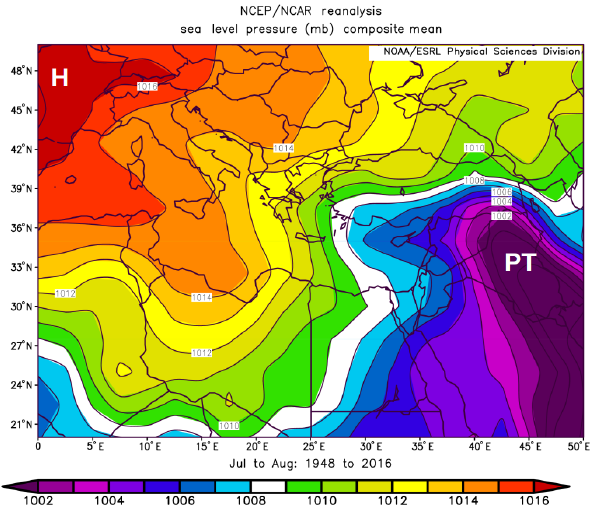
Figure 1. Composite long-term mean sea-level pressure (hPa) for July–August over 1948–2016. “PT” indicates the Persian Trough position. “H” indicates the anticyclone position. NCEP reanalysis data are provided by the NOAA/OAR/ESRL PSD, Boulder, Col- orado, USA; http://www.esrl.noaa.gov/psd/.